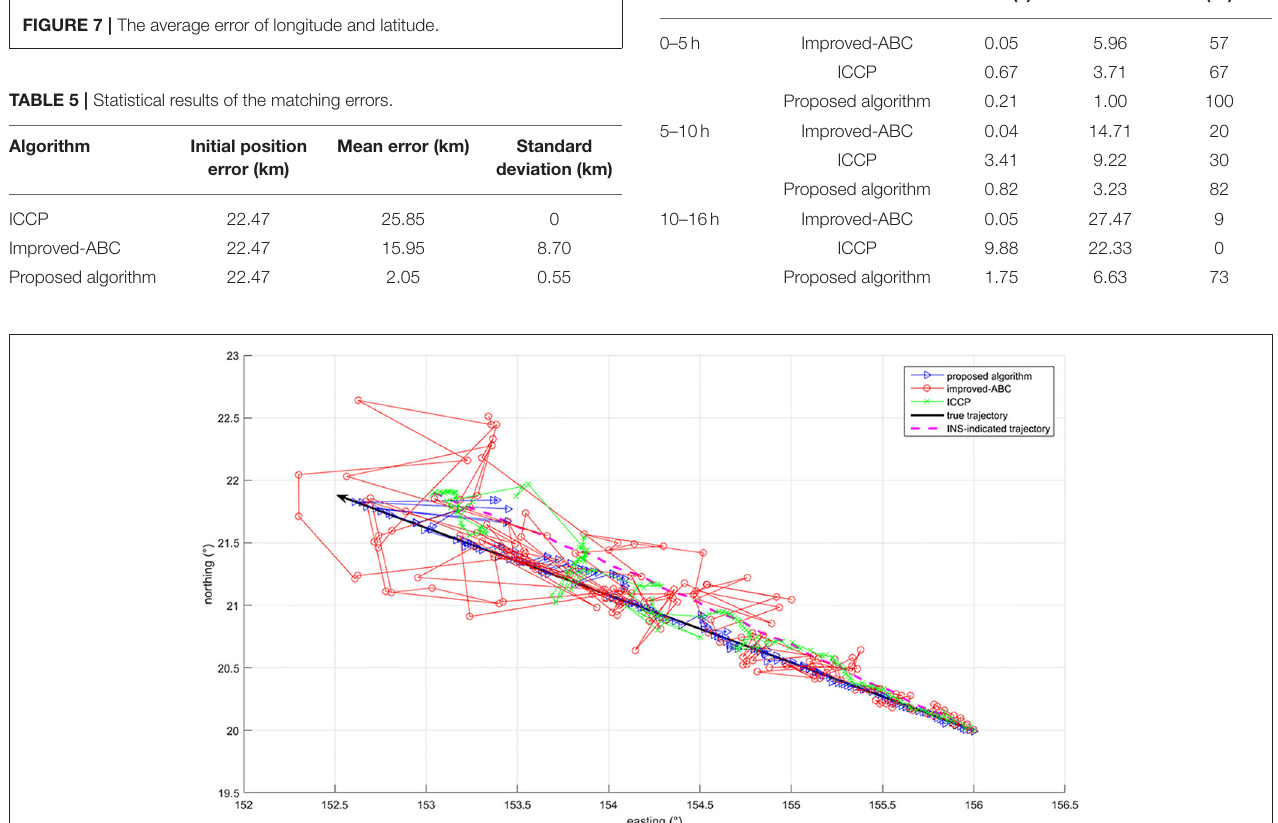
FIGURE 8 | Matching results of the whole